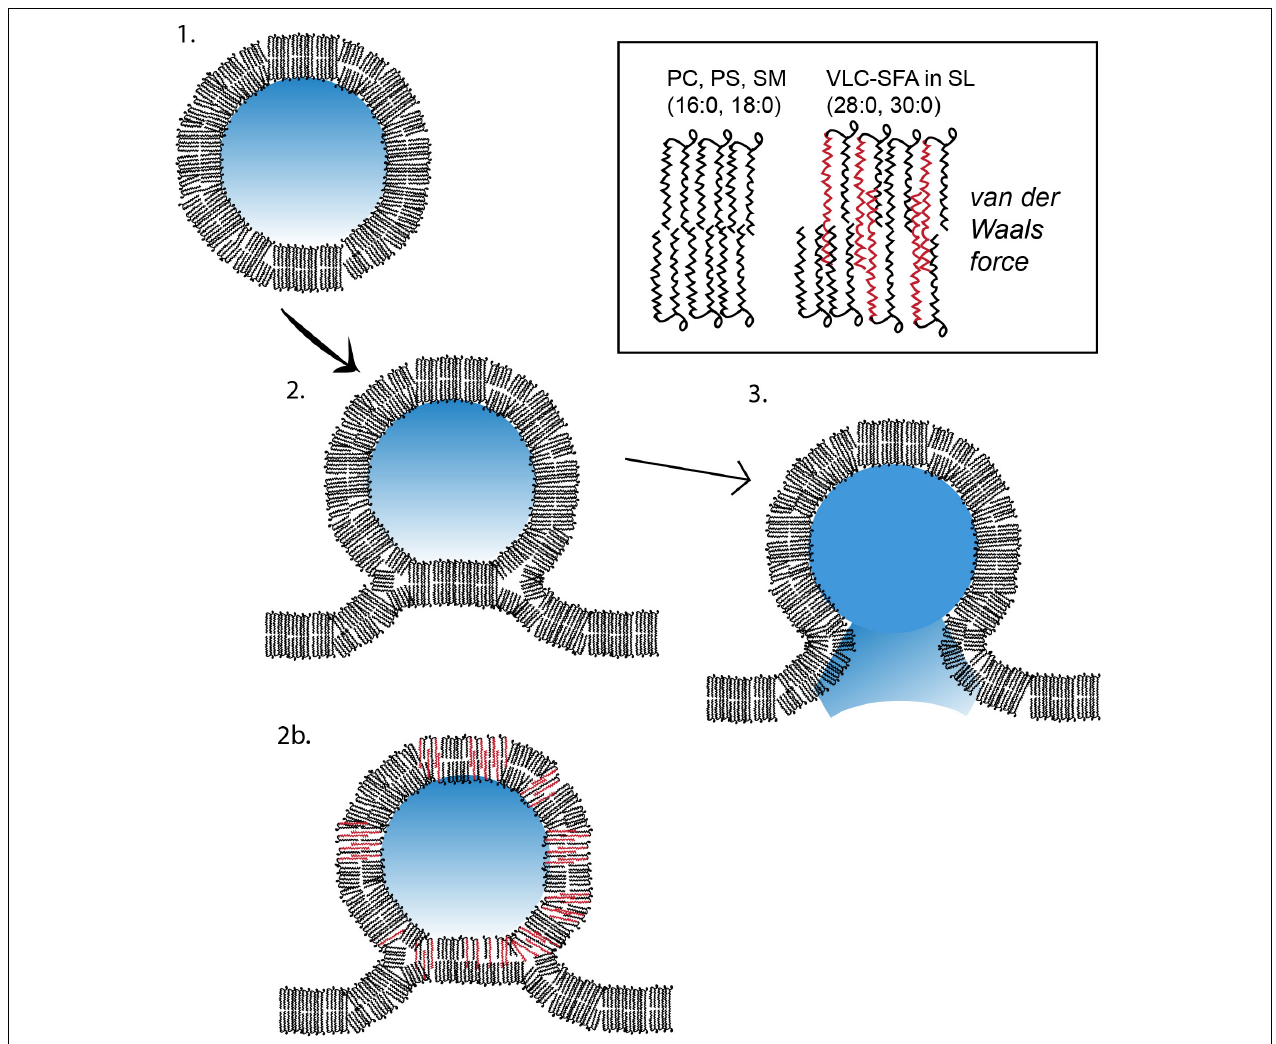
FIGURE 7 | Model of membrane fusion between a VLC-SFA-rich synaptic vesicle and presynaptic active zone membrane. In this cartoon, a synaptic vesicle (SV) containing lipids with common fatty acids (phosphatidylcholine or phosphatidylserine molecules with palmitic, 16:0, and stearic acids, 18:0) is used as a model to illustrate the three stages of synaptic vesicular exocytosis, namely, (1) undocked vesicle; (2) docked and hemifused vesicle stage, with deformation tilt of the membranes and stalk formation; and (3) membrane fusion and contents release stage. In (2b), an SV is depicted with lipids containing, in addition, VLC-SFA (typically 28:0 or 30:0 fatty acid chains, see inset). We have shown that the normal presence of these fatty acids in the SV membrane renders it more stable than do the shorter LC fatty acids, thereby fusing and releasing at comparatively lower rates (Hopiavuori et al., 2018) (PS, phosphatidylserine; PC, phosphatidylcholine; SM, sphingomyelin; SL, sphingolipids; see text for more